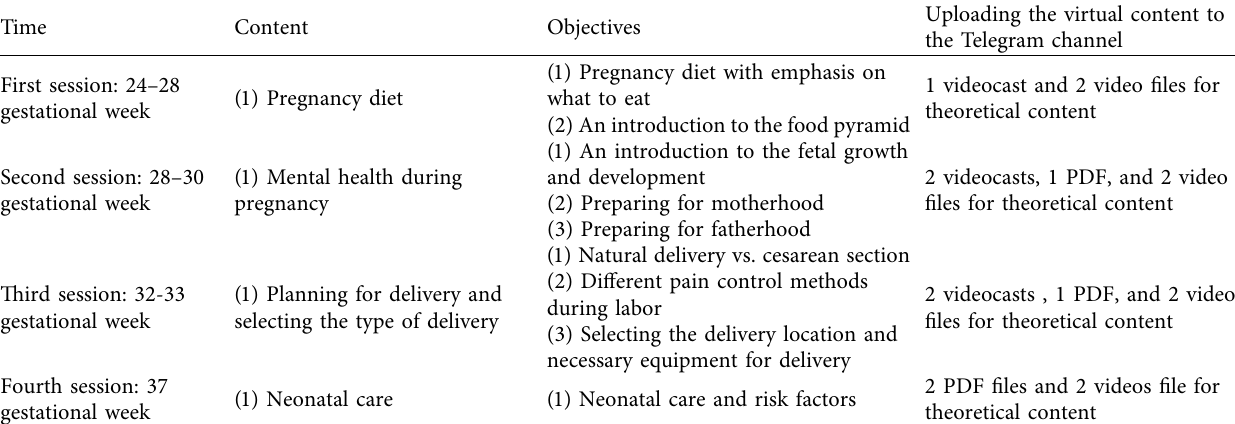
Table 1: The educational content of social media-based training group and face-to-face childbirth preparation courses group.